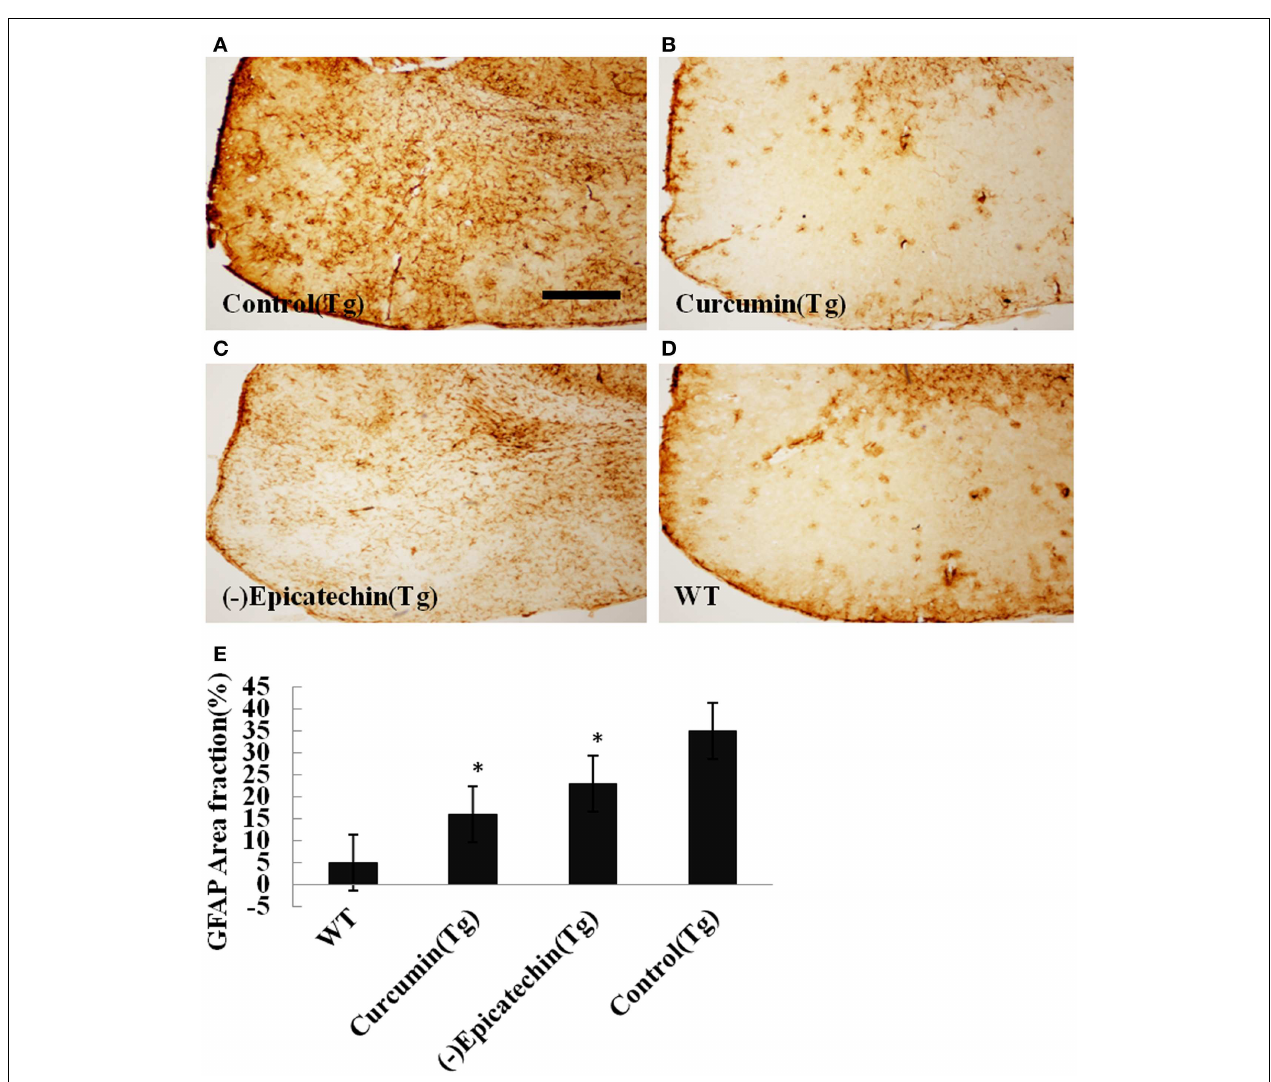
FIGURE 6 | Effects of ( − )epicatechin diet group on astrogliosis in the brain .The area of neocortex and hippocampus was selected for quantification of astrogliosis immunostaining. (A) Astrogliosis in hippocampus and neocortex of APP/PS1 transgenic mice fed with control, (B) transgenic mouse fed with curcumin, (C) transgenic mouse fed with ( − )epicatechin,